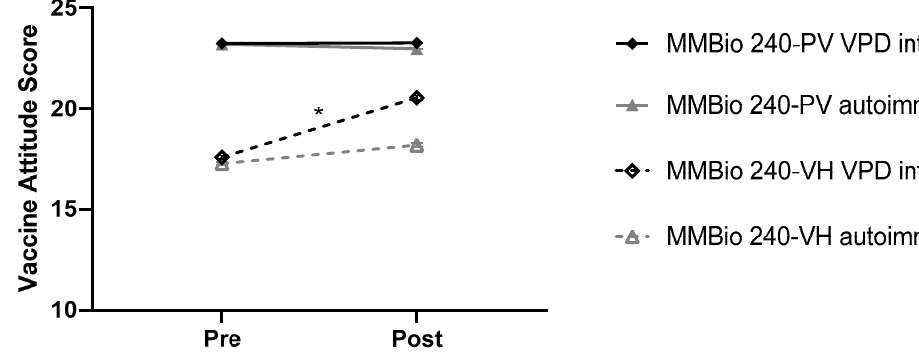
Figure 2. Vaccine-preventable disease interview significantly improves attitudes towards vaccines.